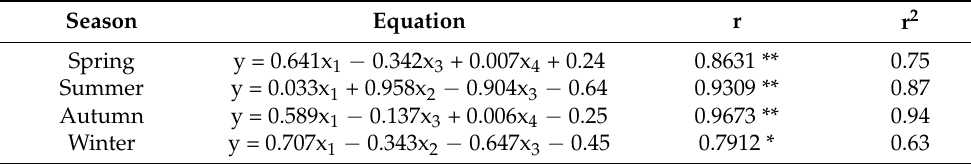
Table 4. Diurnal variation prediction model of temperature based on stepwise regression